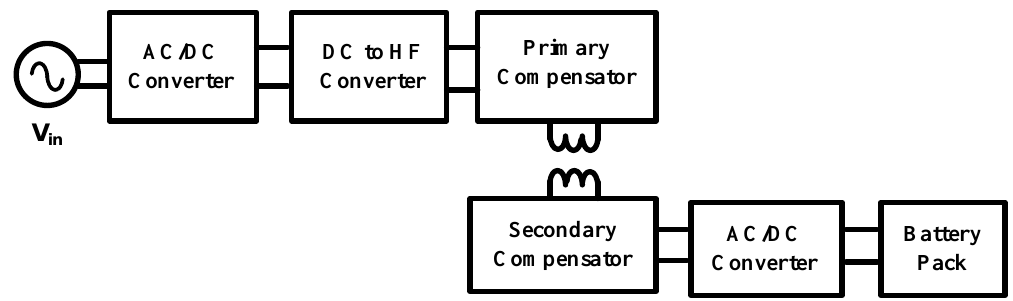
Figure 1. Structure of the inductive power transfer system for electric vehicle (EV) charging.